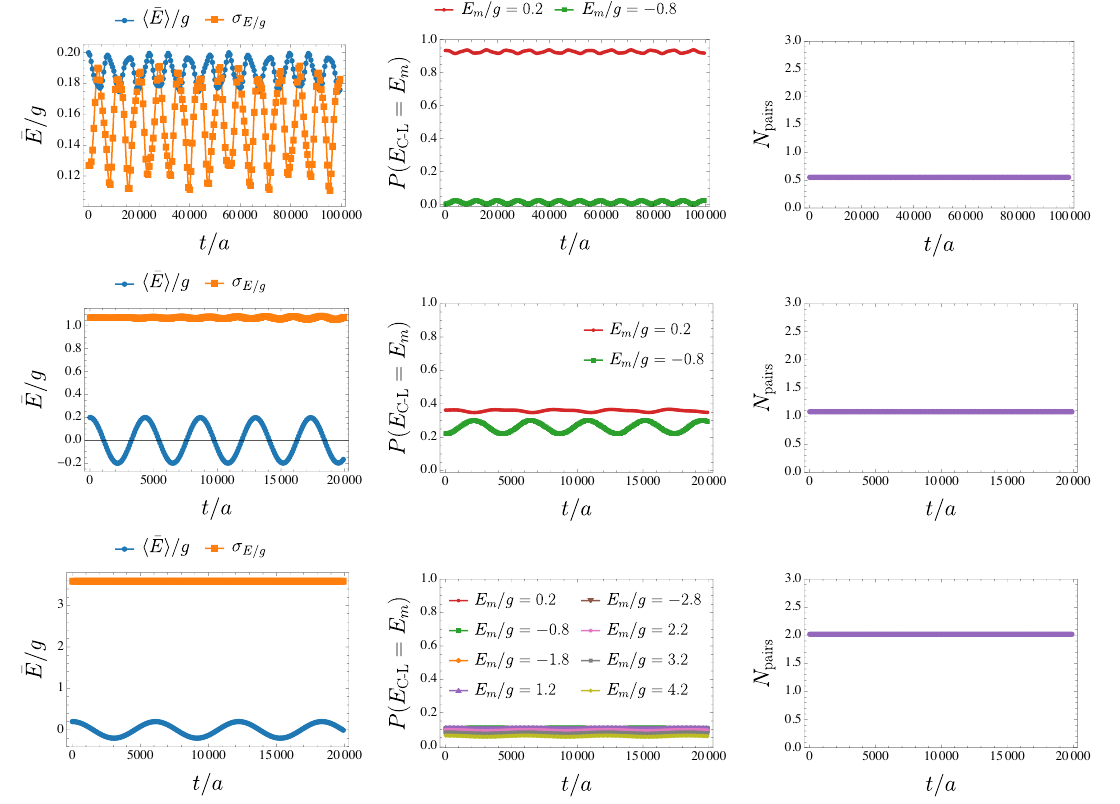
(cid:10) ¯ (cid:11) Figure 5. The expectation values of the spatially averaged electric field E /g , the standard deviation of the spatially averaged electric field σ , the probability to measure field E on the m E/g central link P ( E = E ) , and the number of electron-positron pairs N as functions of time C-L m pairs in the k = 0 . 4 quench for m = 50 , with three different spatial circle sizes mL = 8 (top panel), g mL = 4 (middle panel) and mL = 1 (bottom panel) on an N = 10 lattice. For the same reason as in figure 2, we set l = 10 for mL = 8 , 4 simulations and l = 30 for mL = 1 max max